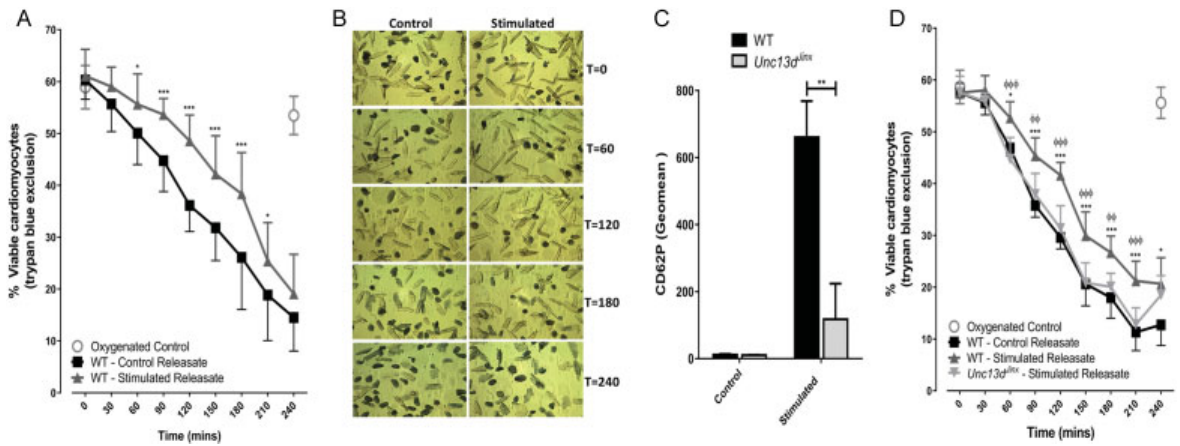
Fig. 1 Factors released from platelet secretory vesicles protect cardiomyocytes from ischemic injury. ( A and D ) Cardiomyocytes from wild-type (WT) hearts preconditioned with released factors from vehicle-treated (control) and collagen-related peptide (CRP)-treated (stimulated) platelets from WTor Unc13d Jinx mice (as indicated) were subjected to ischemic injury using a cell pelleting method. Samples from the pellet were analyzed for cell viability every 30 minutes, for up to 240 minutes, with nonischemic (oxygenated control) samples monitored at 0- and 240- minute time points. Data are mean (cid:4) SD ( n ¼ 7 for ( A ), n ¼ 5 for ( D )), ( A ) (cid:5) p < 0.05, (cid:5)(cid:5)(cid:5) p < 0.001 versus WT-controlled releasate and ( D ) ΦΦ p < 0.01, ΦΦΦ p < 0.001 versus Unc13d Jinx stimulated releasate. ( B ) Representative images of trypan blue stained and nonstained cardiomyocytes at 60-minute intervals throughout ischemia assay (0 – 240 minutes). ( C ) Washed platelets (2 (cid:1) 10 8 /mL) from WT and Unc13d Jinx mice were treated with vehicle control (Tyrode ’ s) or 10 µg/mLCRP and monitored for α -granule secretion by CD62P surface expression. Data are mean (cid:4) SD; n ¼ 3, (cid:5)(cid:5) p < 0.01. Two-way ANOVA with Bonferroni post hoc test for ( A ), ( C ), and ( D